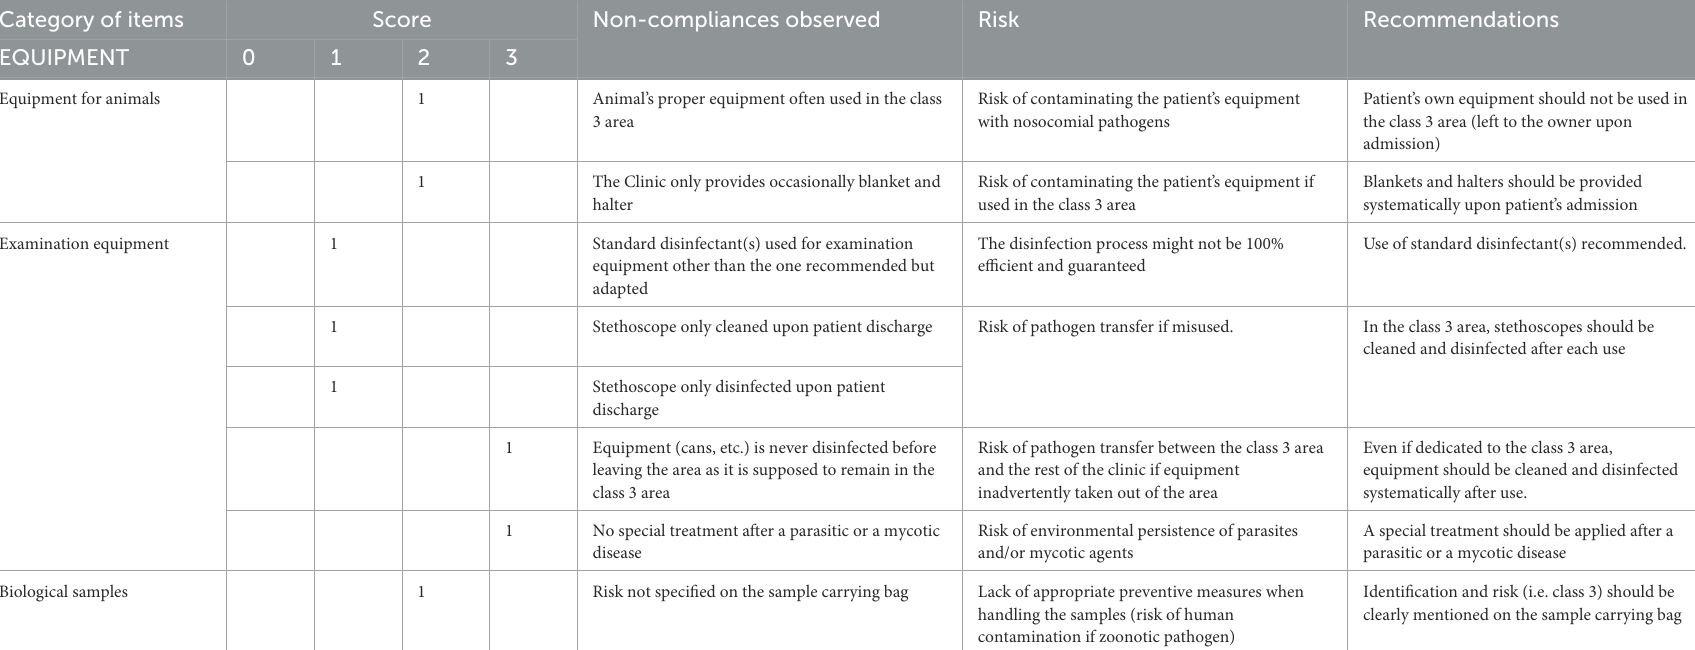
TABLE 2F Biosecurity deficiencies observed when performing the internal audit in the Equine class 3 area—category